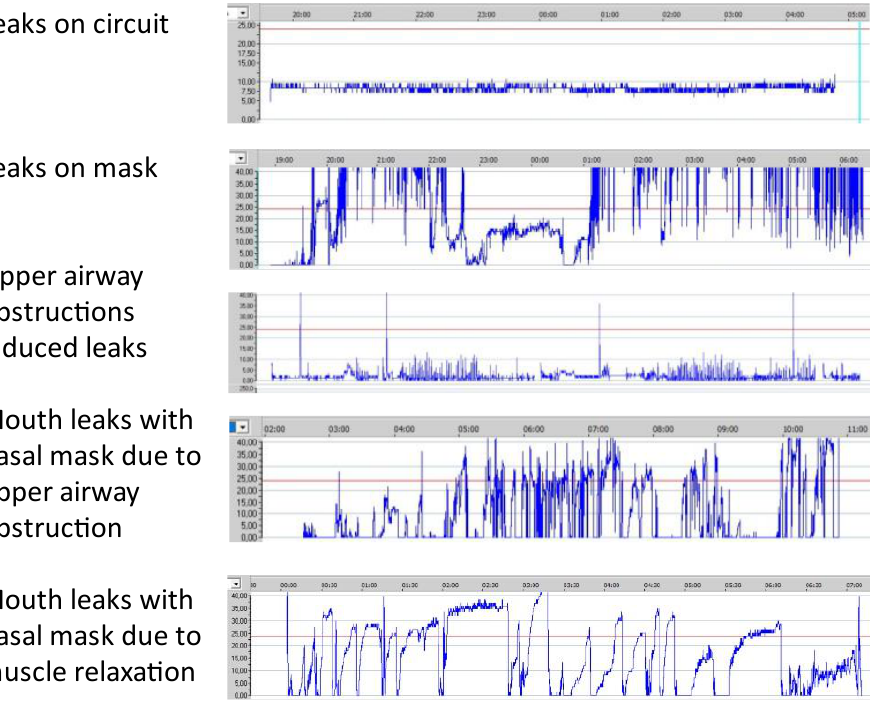
Figure 1. Typical profiles of unintentional leaks repartition overnight.